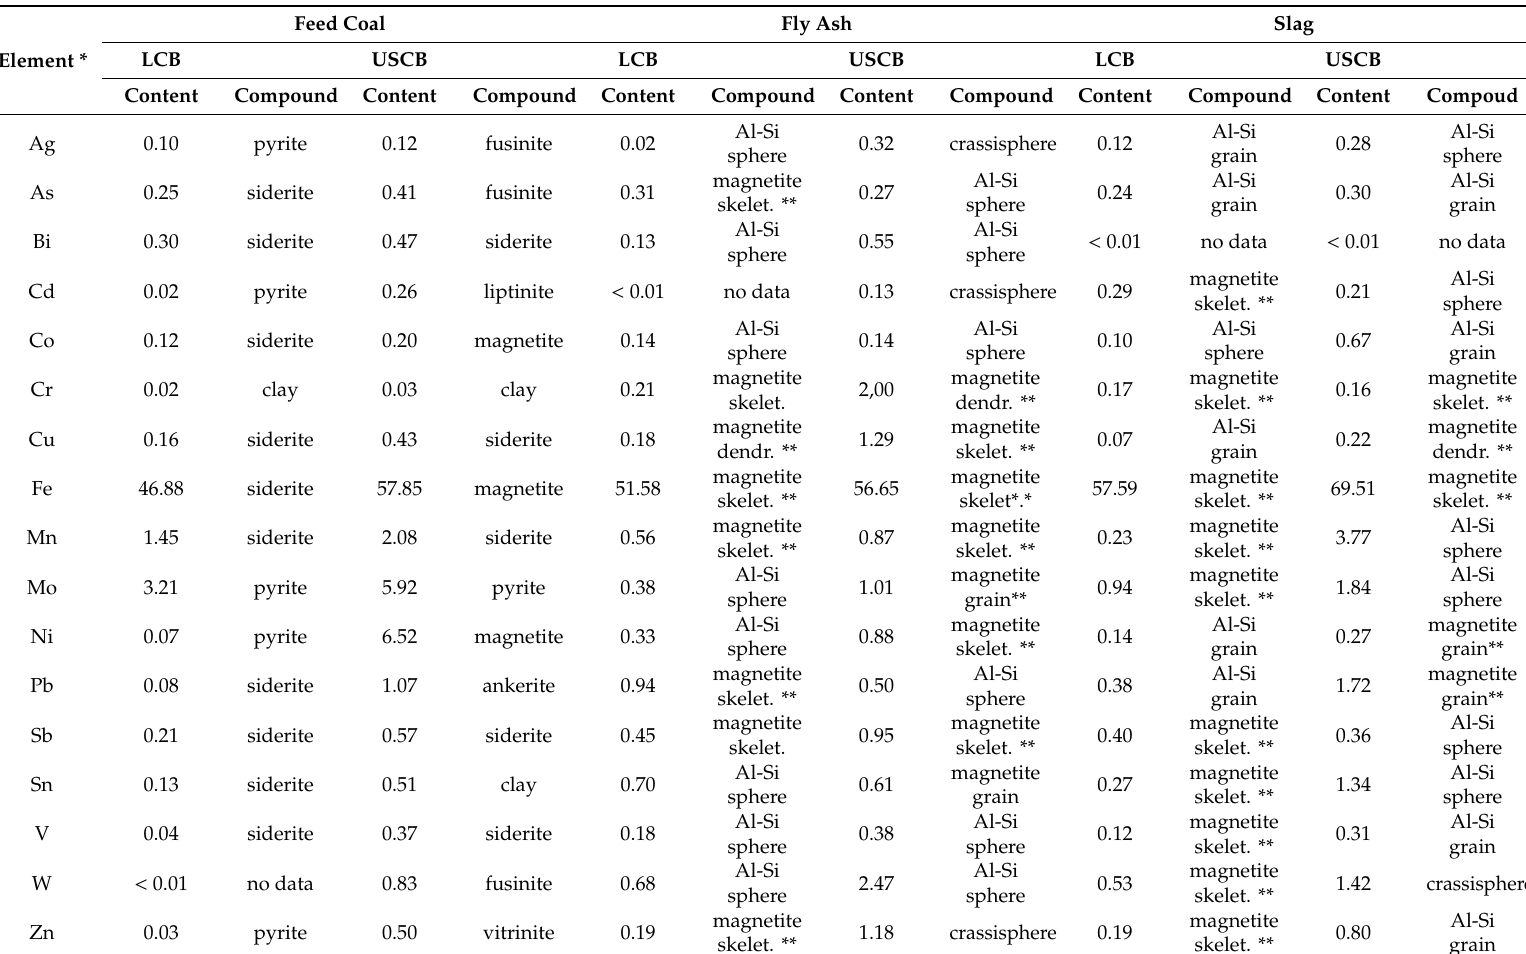
Table 3. Maximum content (wt%) of element in feed coals from the LCB and USCB and in the fly ash and slag obtained by the SEM / EDS